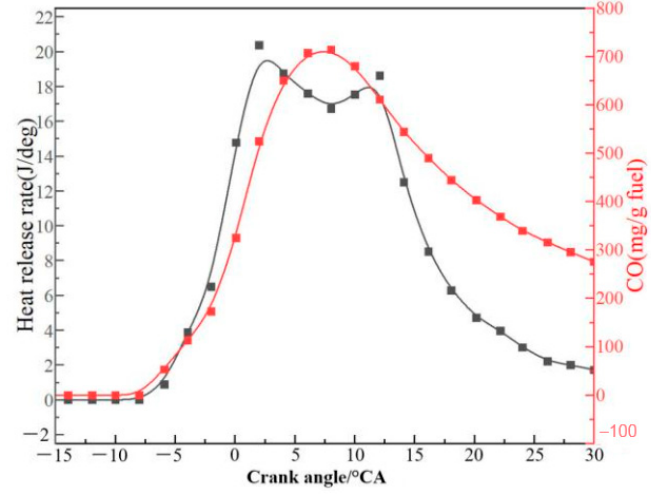
Figure 12. Variation of heat release rate and CO with crankshaft angle.